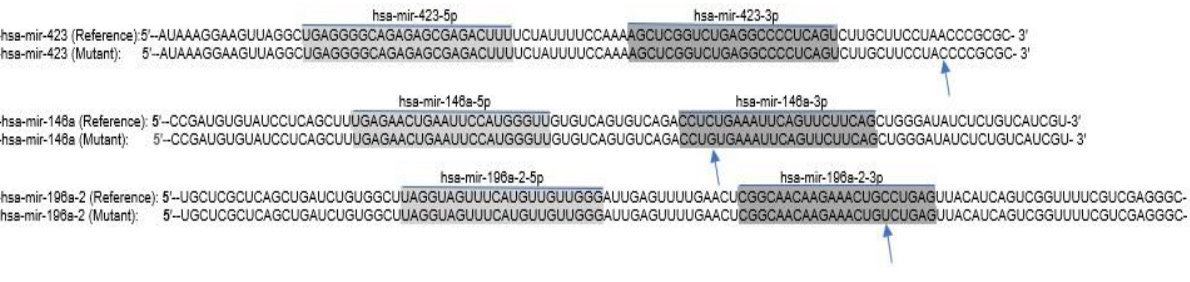
Figure 1. The primary sequences of hsa-miR-423 (reference: A ), (mutant: B ), hsa-miR-146a (reference: C ), (mutant: D ), hsa-miR-196A2 (reference: E ), (mutant: F ).